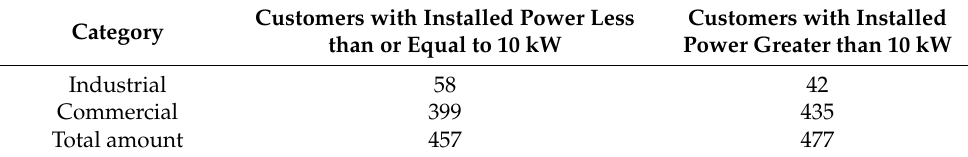
Table 1. Clients considered in the study, according to the 10 kW